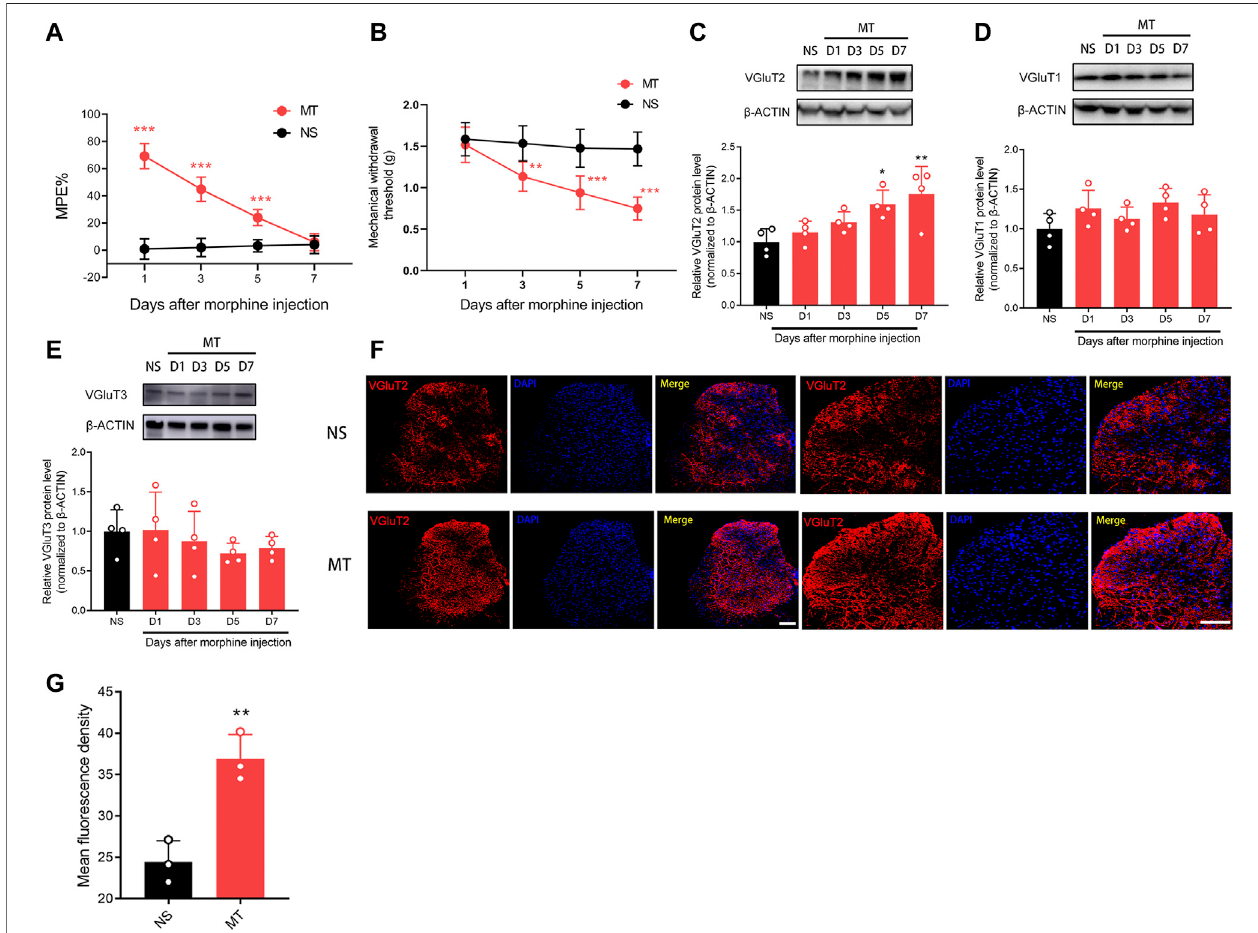
FIGURE 1 | Repeated administration of morphine increases VGluT2 expression in the spinal cord (A) Time course of morphine tolerance assessed by the tail- fl ick test in mice. Tail fl ick test was performed 30 min before morphine (MT) or saline (NS) injections, 30 min later, the test was performed again. n = 8 mice. MT versus NS, two-way ANOVA, F (1, 14) = 228.2, p < 0.001 with Bonferroni correction. *** p < 0.001, compared with NS (B) Mechanical pain threshold before morphine or saline injections. n = 8 mice. MT versus NS, two-way ANOVA, F (1, 14) = 37.2, p < 0.001 with Bonferroni correction. ** p < 0.01, *** p < 0.001, compared with NS (C-E) Time course of VGluT1-3 protein level changes in the spinal cord after repeated morphine administration. n = 4, one-way ANOVA (C) F (4, 15) = 5.749, p = 0.0052 (D) F (4, 15) = 1.555, p = 0.2372 (E) F (4, 15) = 0.6829, p = 0.6146 with Bonferroni correction. * p < 0.05, ** p < 0.01, compared with NS (D7) (F,G) Representative immuno fl uorescent images (F) and quantitative summary (G) showing that VGluT2 expression is increased in the lumbar spinal cord after morphine injection on day 7 after morphine administration. Scale bars, 100 μ m, n = 3. Student ’ s unpaired t -test, t = 5.550, p = 0.0052. ** p < 0.01, compared with NS.